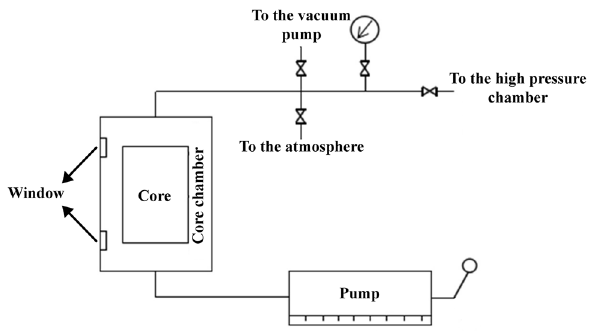
Fig. 6 Experimental setup of the mercury intrusion porosimetry test